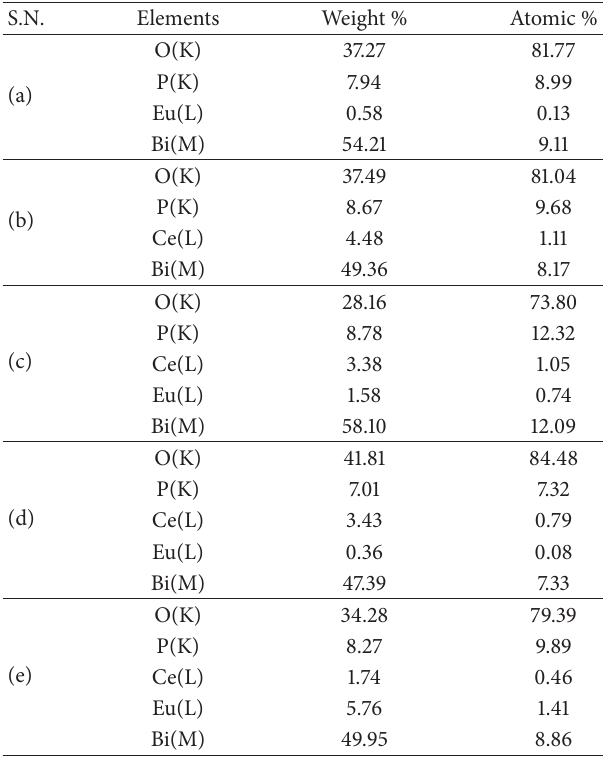
Table 1: Elemental composition data obtained from EDAX profiles doped with (a) 1.0 mol% Eu 3+ , (b) 5.0 mol% Ce 3+ , of BiPO 4